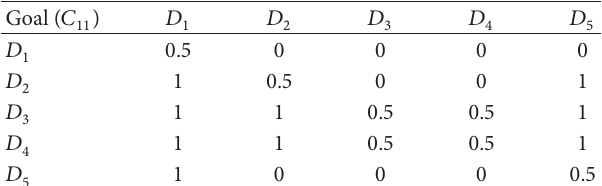
Table 4: Evaluation of 𝐶 𝑖